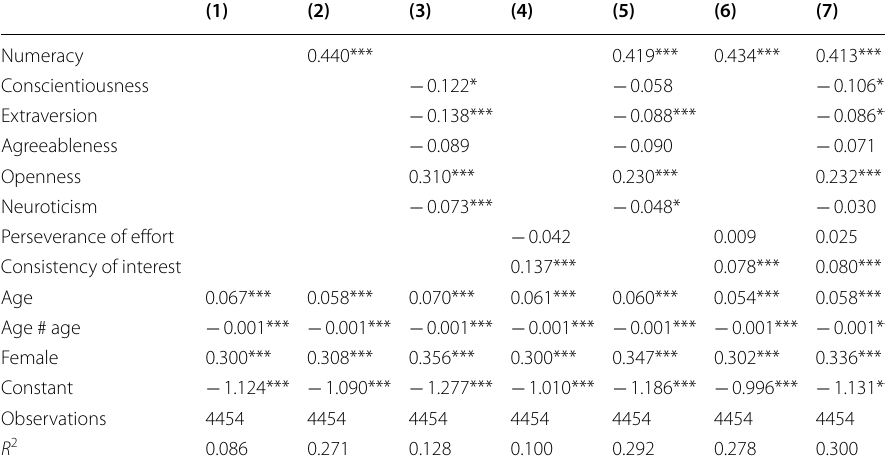
Table 10 Educational attainment and cognitive and non-cognitive skills (without control- ling for